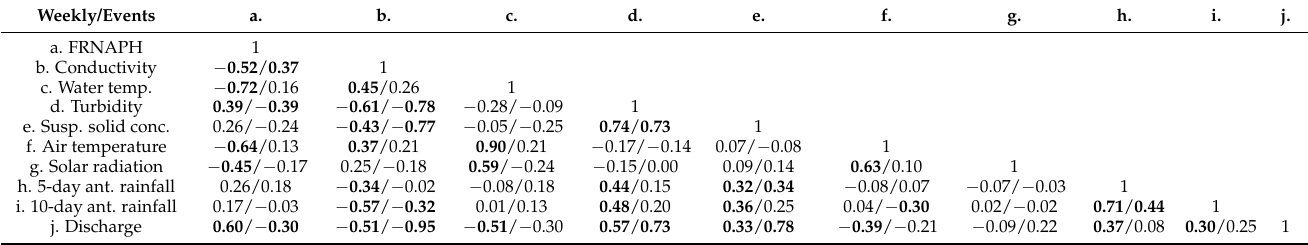
Table 2. Spearman correlation analysis between FRNAPH and suspended solid concentrations, hydrological and meteoro- logical variables for the ‘Weekly’ and the ‘Events’ dataset (Weekly/Events). Values with significant correlations ( p < 0.01) are in